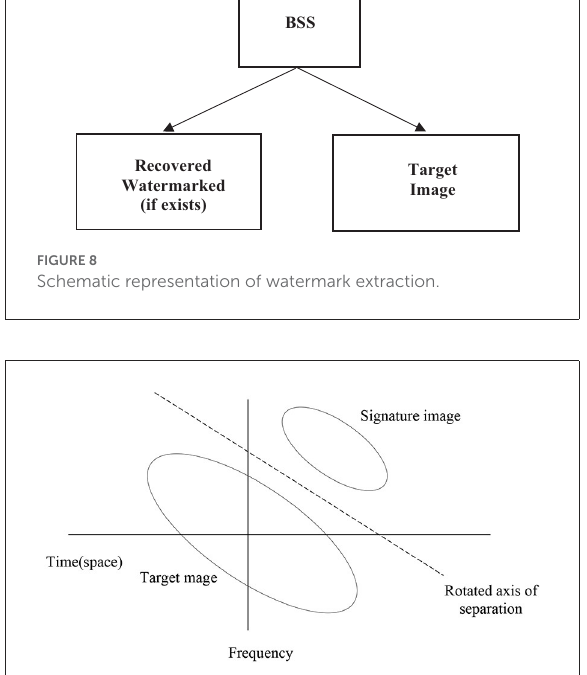
FIGURE9 A view of the Wigner’s plane in the watermarking scheme.